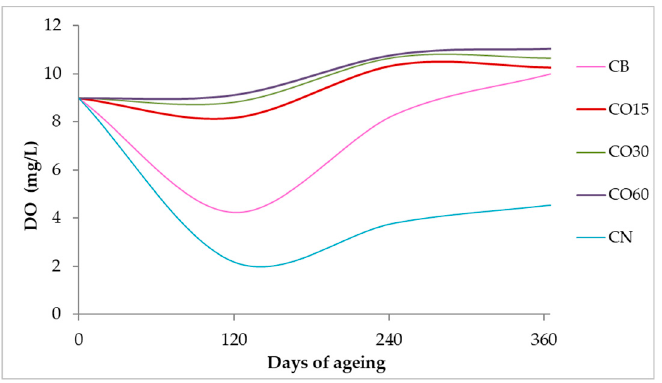
Figure 1. Average dissolved oxygen content in each ageing modality, during the ageing period (adapted from [24]). (adapted from